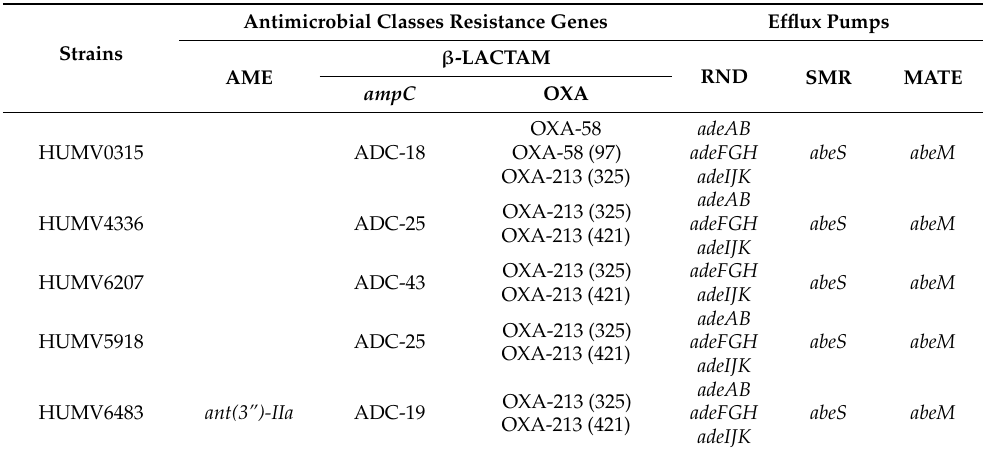
Figure 2. Number of protein-coding sequences distributed in each subsystem category according to RAST annotation. Each bar shows the average of 5 clinical strains ± SE (standard error). Along with RAST, Prokka annotation was also performed, and through the different databases, many determinants of resistance were identified (Table 3). The strain HUMV6483 was the only one that encoded an aminoglycoside-modifying enzyme, ant(3 ″ )-IIa . All the strains also harbored one β -lactam class C gen ( ampC ) from four differ- ent allotypes, and at least two oxacillinases ( bla OXA-213 was present in all the genomes, and HUMV0315 also harbored bla OXA - 58 ), being the most common allotype bla OXA - 325 , present in the five isolates. Because HUMV0315 is the only meropenem resistant strain, bla OXA - 58 might be responsible for that phenotype. Table 3. List of antimicrobial resistance genes and antimicrobial efflux pump genes identified with Prokka and CARD databases in clinical A. pittii